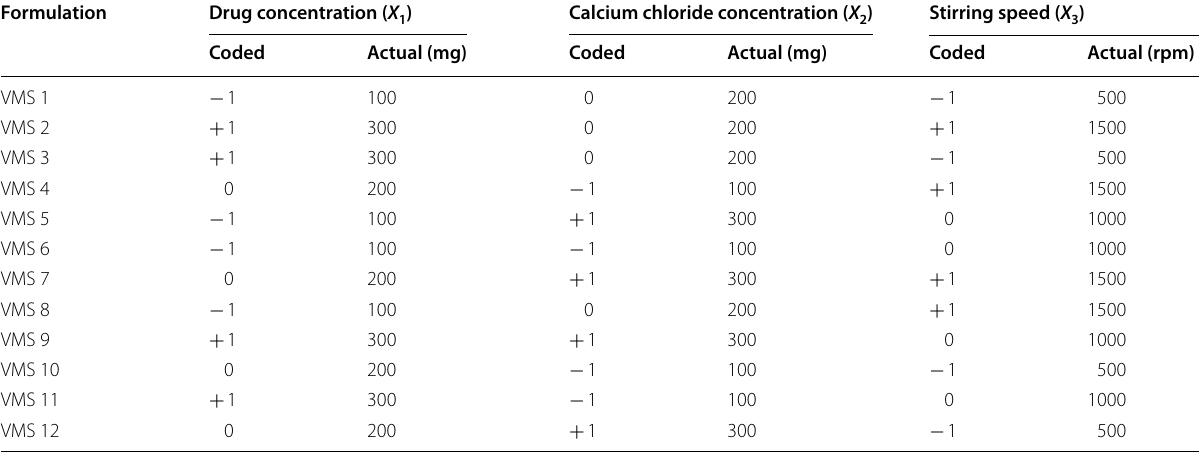
VMS Vancomycin HCl microspheres